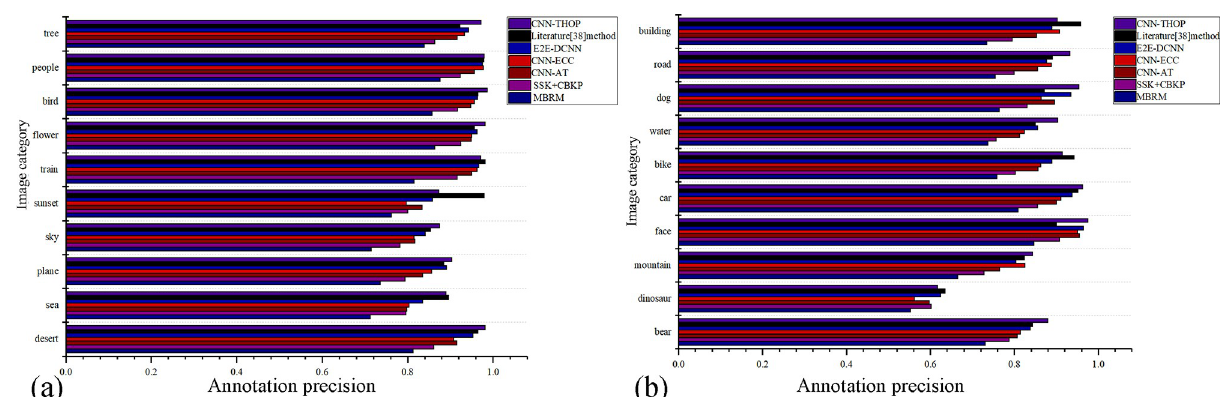
Fig 5. Experimental comparison of a single class precision using different algorithms.